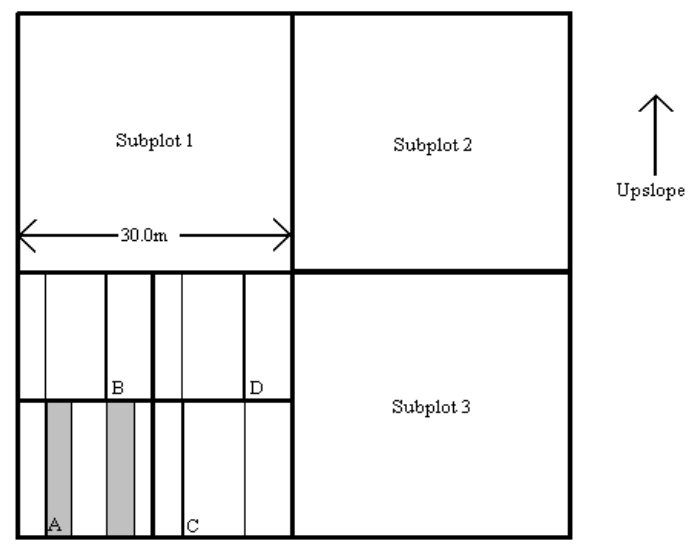
Figure 3. General layout of line transects and strip plots for a representative subplot.